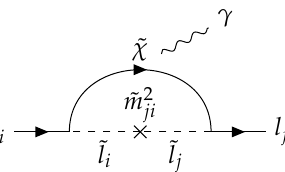
Figure 9. l i → l j γ in SUSY through sleptons mass mixing. ˜ χ correspond to charginos and neutralinos (mass eigenstates of electroweak gauginos and